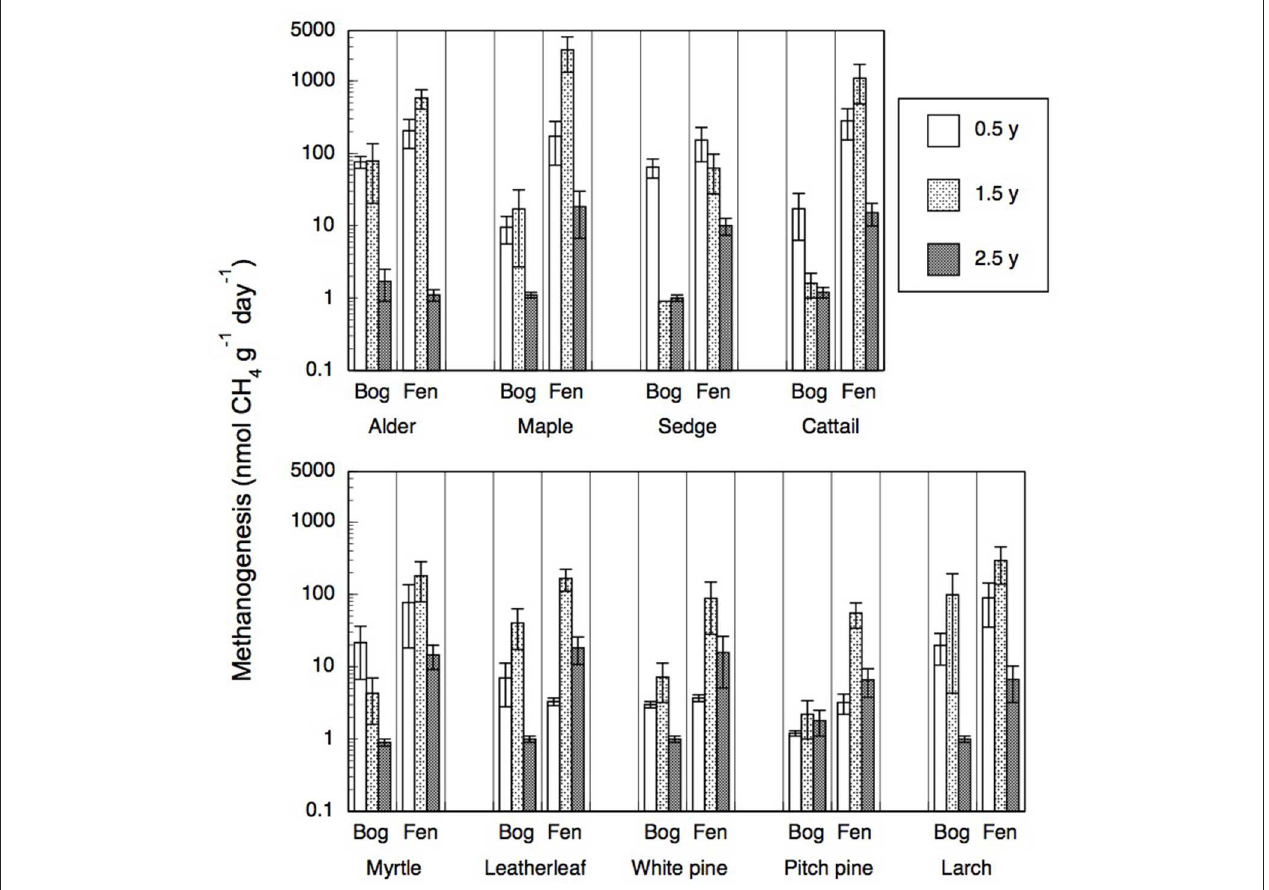
FIGURE 2 | Rates of methanogenesis (nmol CH 4 g − 1 dry residue d − 1 ) by leaf litter residue from nine species having decayed in bogs or in rich fens for three amounts of time. Values are mean + standard error; n = 10 for 0.5 year, n = 4 for 1.5 years, n = 5 for 2.5